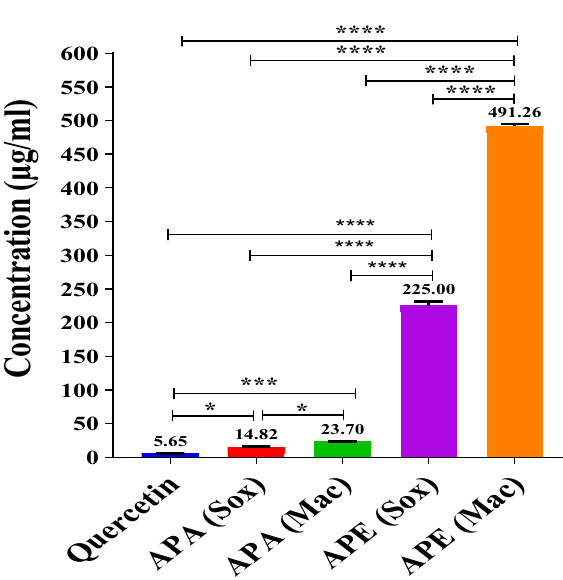
Figure 3. DPPH radical-scavenging activity: The comparison of the IC 50 values of A. precatorius seed extracts; APA (Sox) (1–21 µg/mL), APA (Mac) (1–29 µg/mL), APE (Sox) (150–170 µg/mL), APE (Mac) (150–650 µg/ mL), and quercetin (1–21 µg/mL) at various concentrations. The significance between various groups was tested using one-way ANOVA where (*) p = 0.0308, (***) p = 0.0003, (****) p <